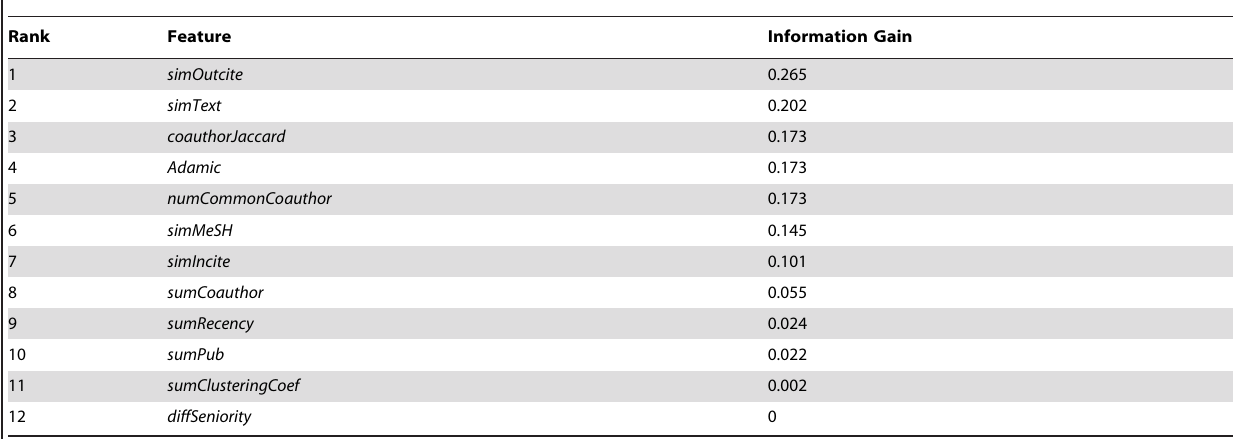
Table 6. Training set feature ranking, by information gain.